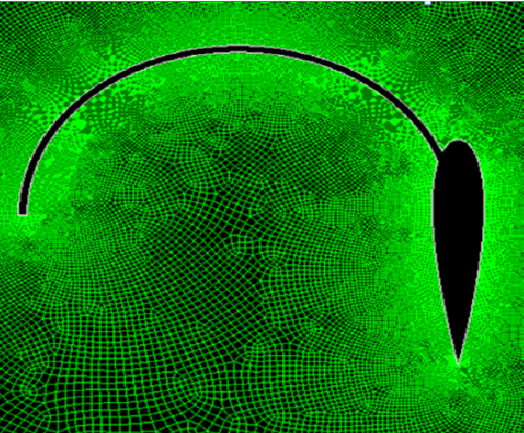
Figure 7. Grid mesh of geometric structure of lift-drag